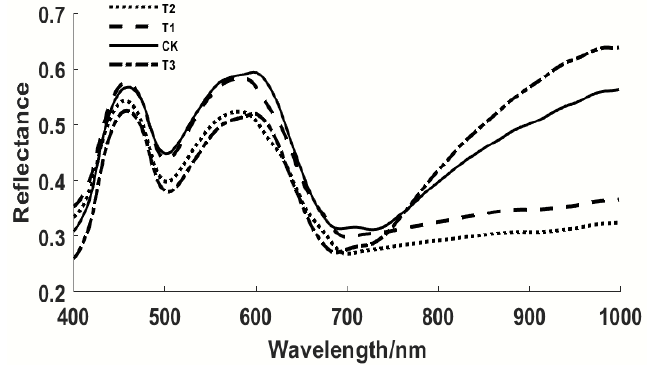
Figure 3. Average spectral curves of different salt concentrations.